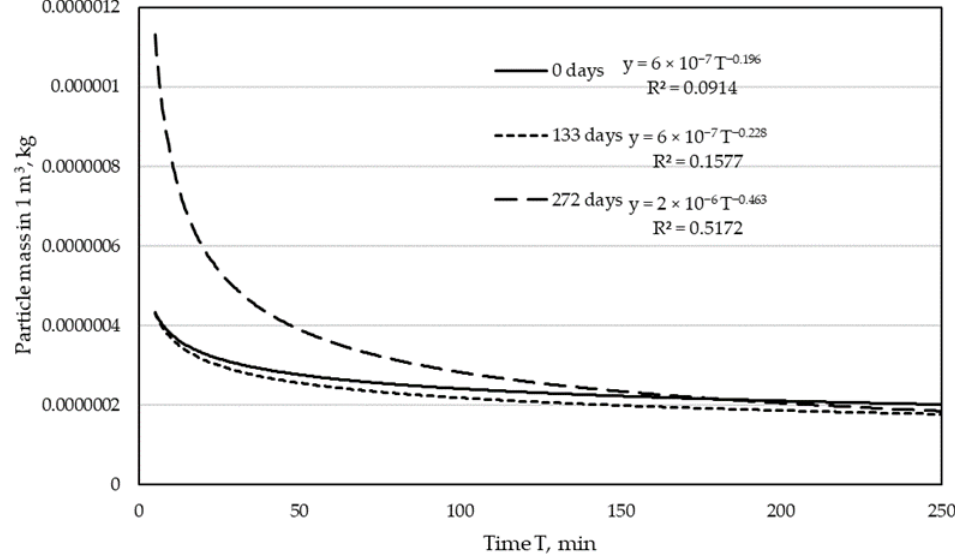
Figure 3. Particle mass in purified air for a drilling centers line.